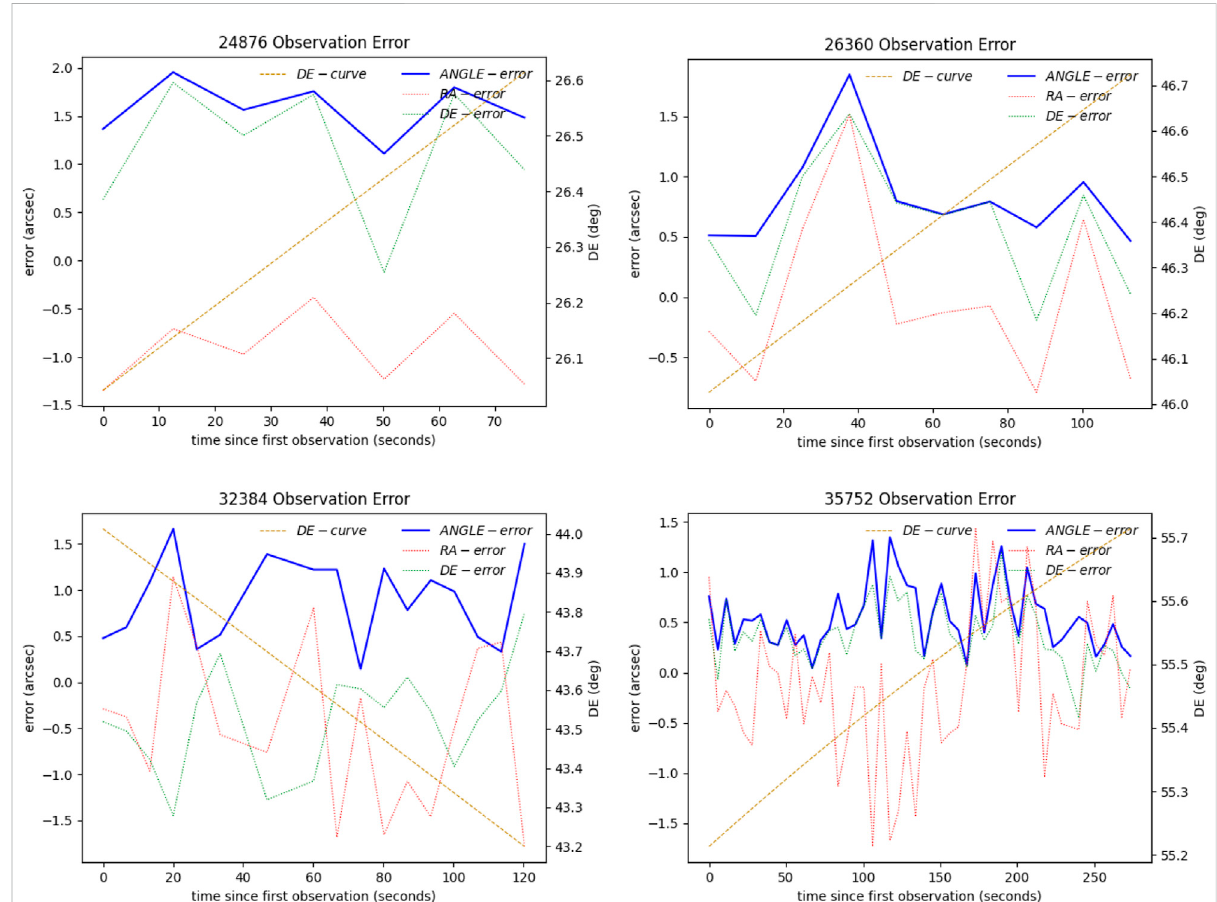
FIGURE 7 The tracking performance of the telescope. The NORAD code of the four GPS satellites (in MEO) are 24,876, 26,360, 32,384, and 35,752 respectively. The blue line (ANGLE-error) represents error synthesized by the two axes, the red line (RA-error) and green line (DE-error) represent the error of the right ascension axis and the declination axis respectively, and the brown line (DE-curve) represents the change of the declination value in the observation